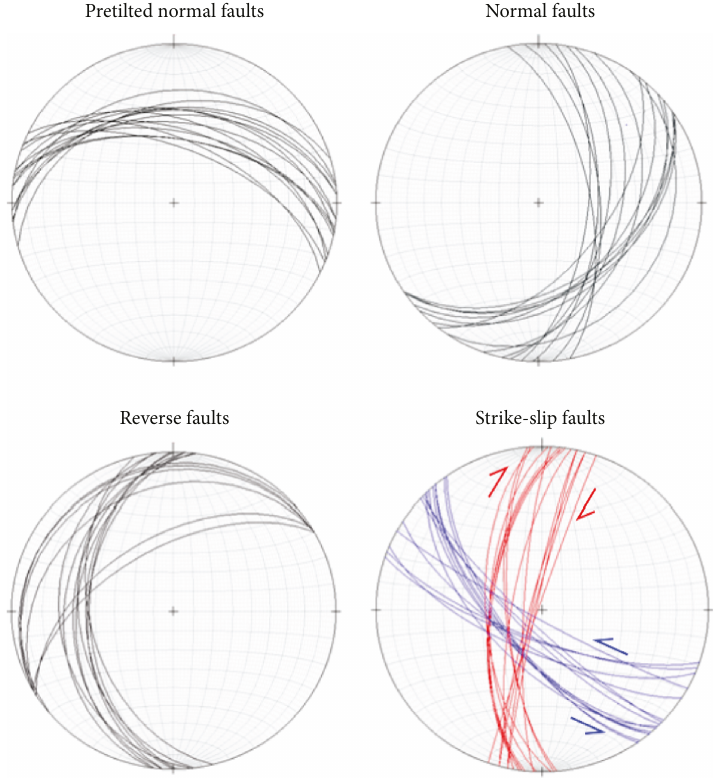
Figure 17: Stereoplots of fault orientations in Vallone di Santo Spirito, Maiella